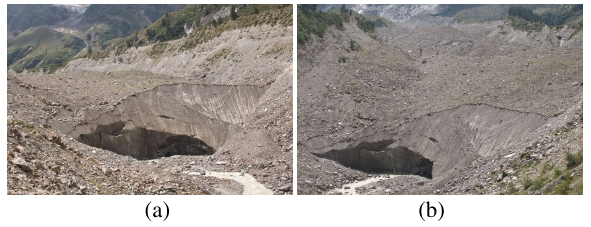
Figure 8. Example of a stereo-pair of images acquired by the two cameras on 28/07/22 at 14:00. (a) Image taken from Camera 1 (located on the stream-wise right moraine); (b) Image from Camera 2 (stream-wise left